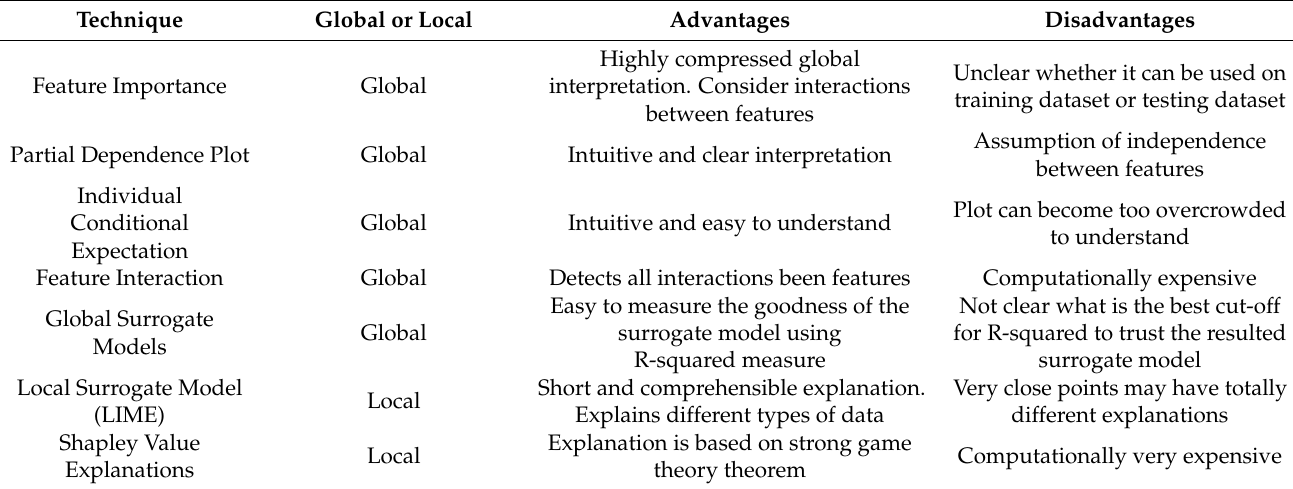
Table 2. Main features of different XAI techniques (sources: